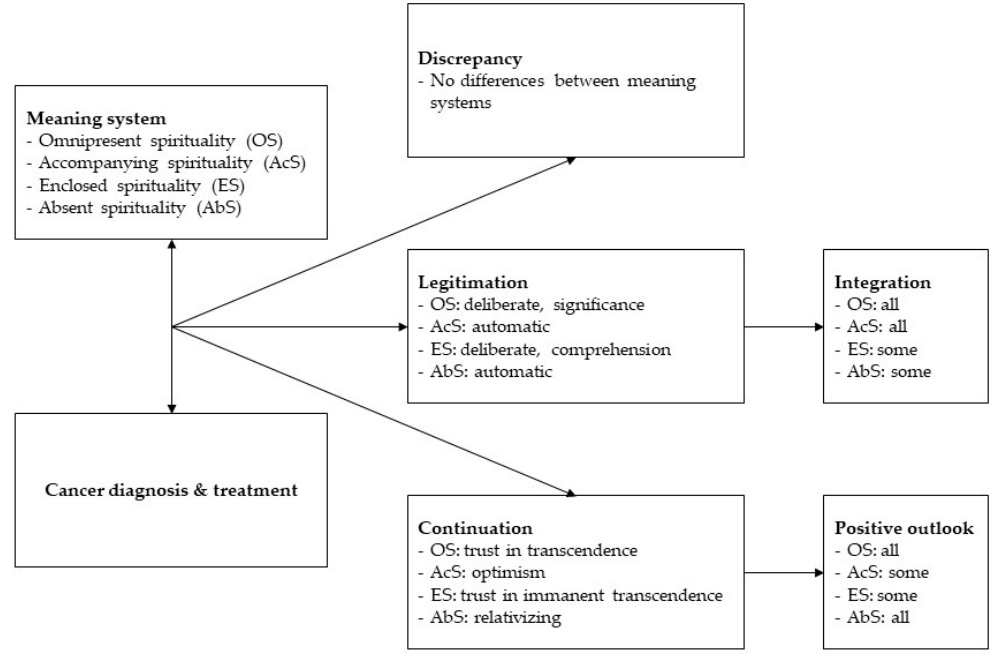
Figure 1. Summary of findings on the role of the meaning systems in coping with cancer.